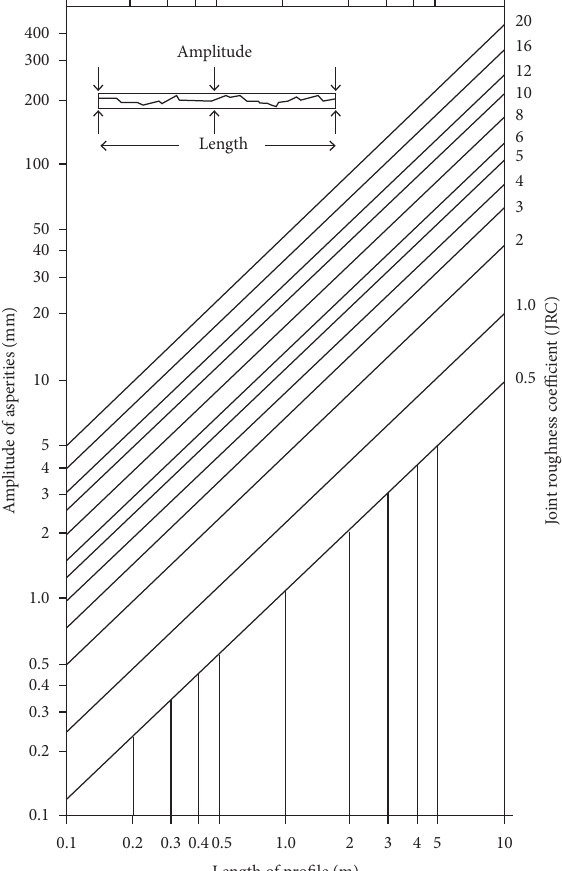
Figure 5: Barton’s straight edge method.